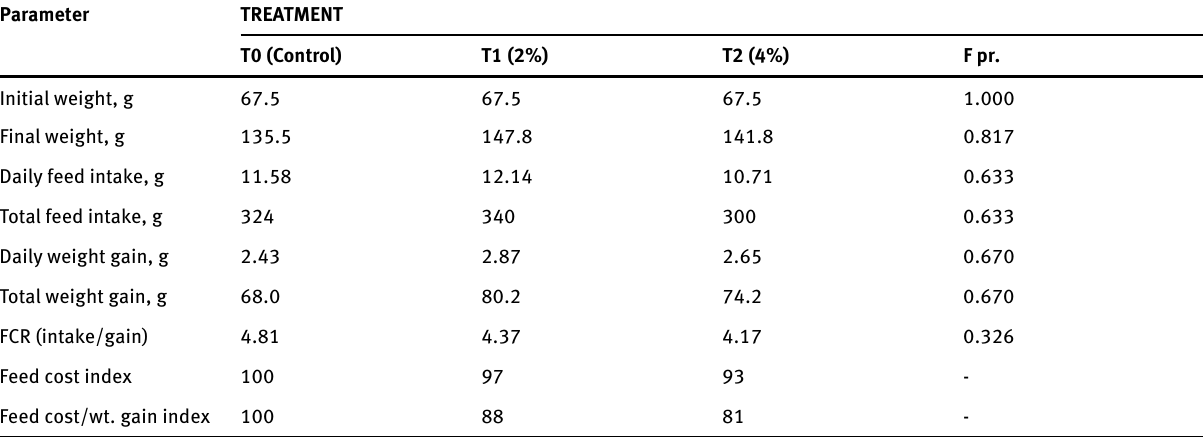
Table 3: Growth Performance of Rats and Economics of Production